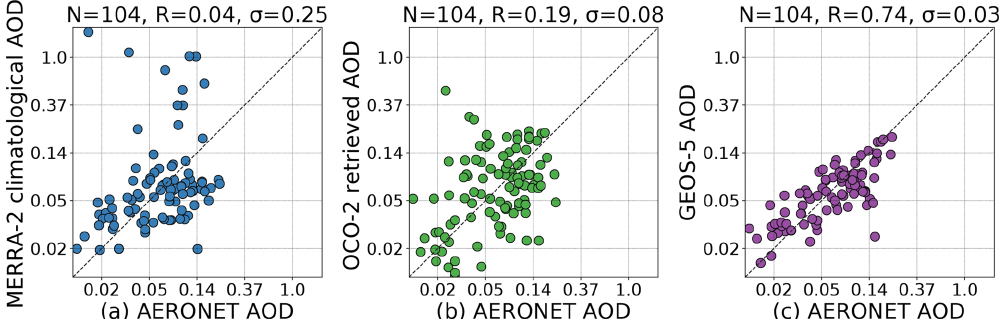
Figure 3. (a) MERRA-2 climatological AOD vs. AERONET AOD. (b) OCO-2 V8 retrieved AOD vs. AERONET AOD. (c) GEOS-5 co- located AOD vs. AERONET AOD. The AERONET AODs are the means of the AODs at 675 and 870nm. Overpass means are plotted. AERONET stations used were those present at the TCCON sites selected for this study, listed in Table 1 and shown in Fig. 2, that had valid data between 17 September 2014 and 2 May 2016.